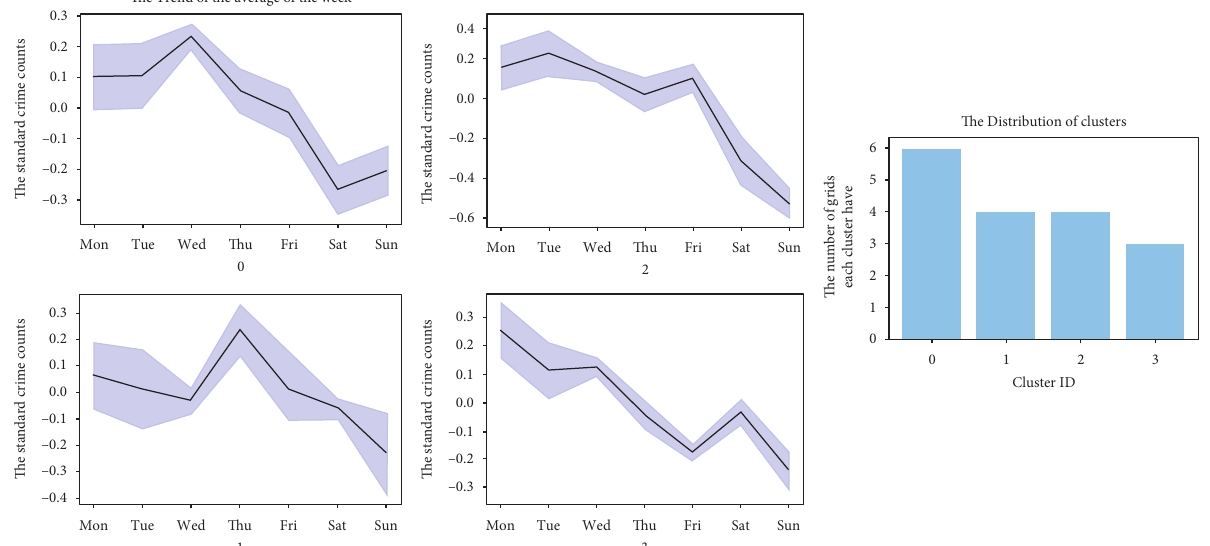
Figure 16: The theft in Philadelphia trends in the average week in 2018 and the distribution of clusters. The line charts are the weekly trends of theft in Philadelphia in 2018. The bar chart is the distribution of the